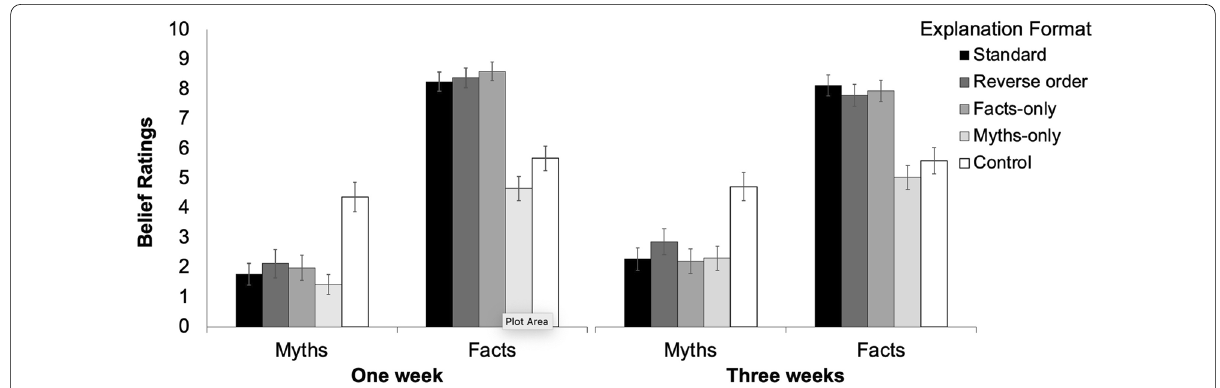
Fig. 4 Belief ratings across conditions in Experiment 4. Error bars denote 95% confidence intervals